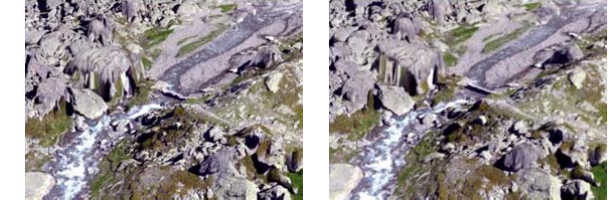
Figure 9: Comparison of a Section of the DTMs Left: DSM from TLS, Right: DSM from